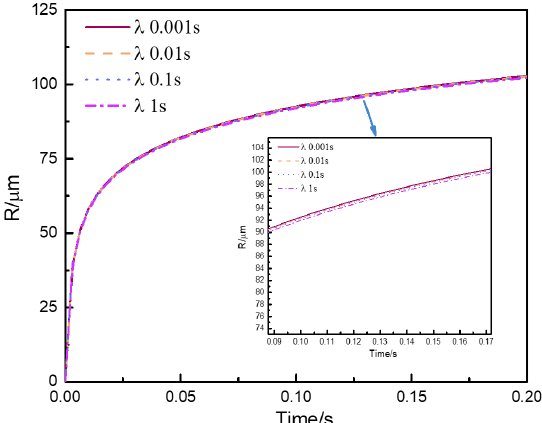
Figure 11. Effect of characteristic relaxation time ( λ 𝑐 ) on predicted bubble growth behaviors.